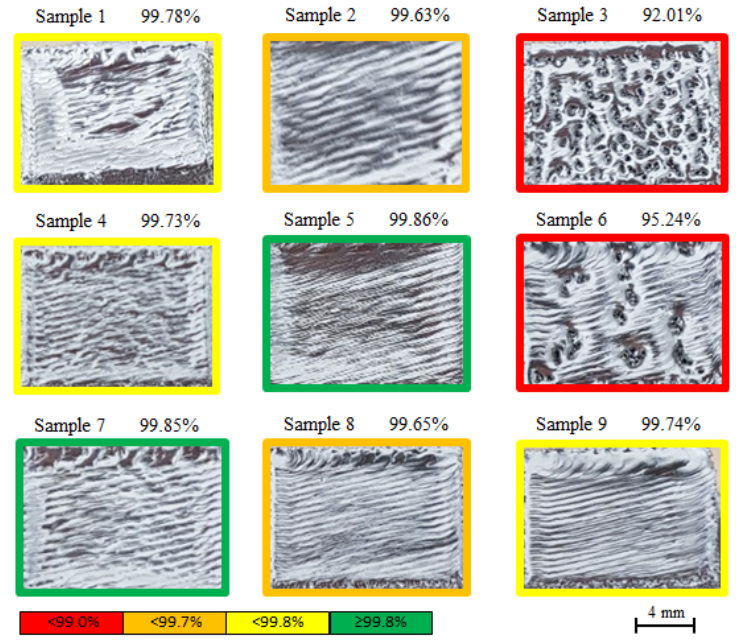
Figure 3. The top surface of representative samples from each set.